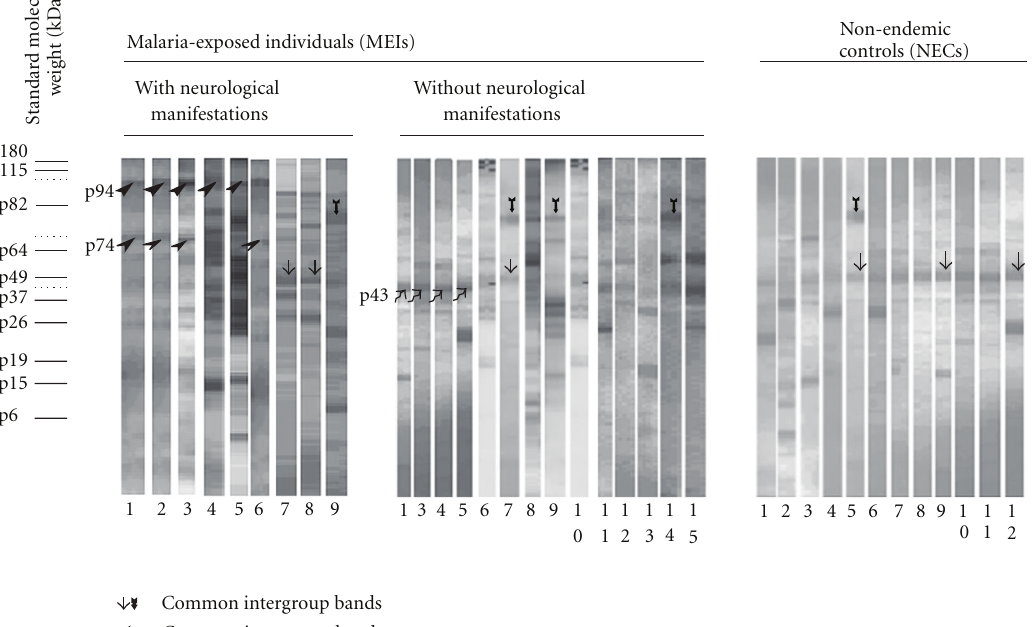
Figure 1: Representative IgG autoreactive patterns obtained with plasma from subjects living in malaria endemic area. The tested plasmas were obtained from malaria-exposed individuals (MEIs) with or without neurological manifestations, of all ages (from 1 to 86 years old). In parallel nonexposed healthy subjects called nonendemic controls (NECs) were also evaluated. For these western blot analyses, protein extracts of the central nervous system (CNS) tissue collected in one subject with no history of neurological disease were used as antigenic targets. Despite the heterogeneous band patterns, comparison of the strips allowed identification of some singular antigenic bands. Some bands were shared by di ff erent groups of subjects (vertical arrows). In contrast, other bands were specifically found in some groups of subjects (diagonal arrows). As illustrated, p94 and p43 protein bands were specifically found in either MEI with neurological symptoms or in MEI without neurological